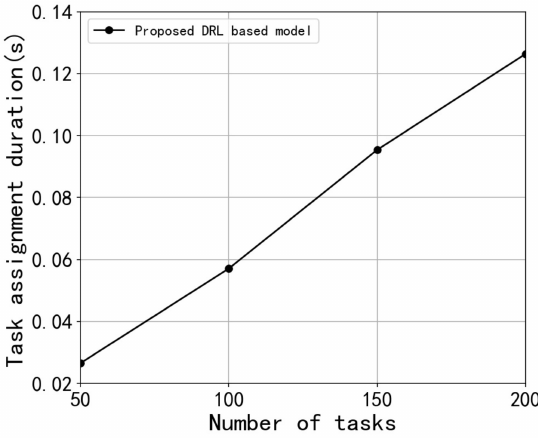
Figure 9. Task assignment duration using our proposed model.